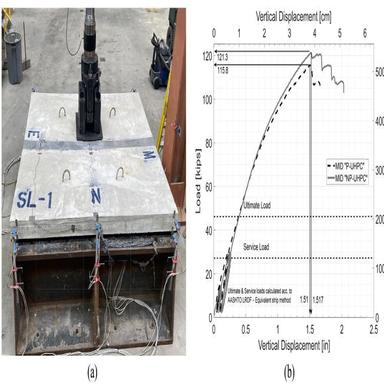
(a) Test setup of precast deck assembly with longitudinal NP-UHPC field joint; (b) comparison of load–deflection relationships of specimens with proprietary UHPC and ABC-UTC NP-UHPC.